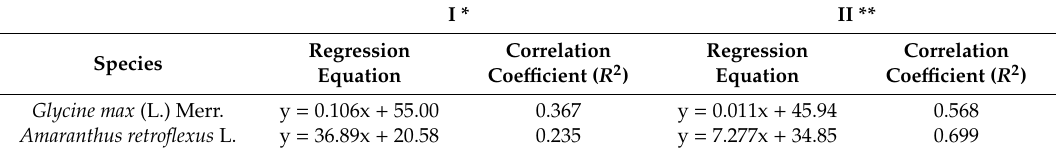
I * II ** Regression Correlation Regression Correlation Equation Coe ffi cient ( R 2 ) Equation Coe ffi cient ( R 2 )